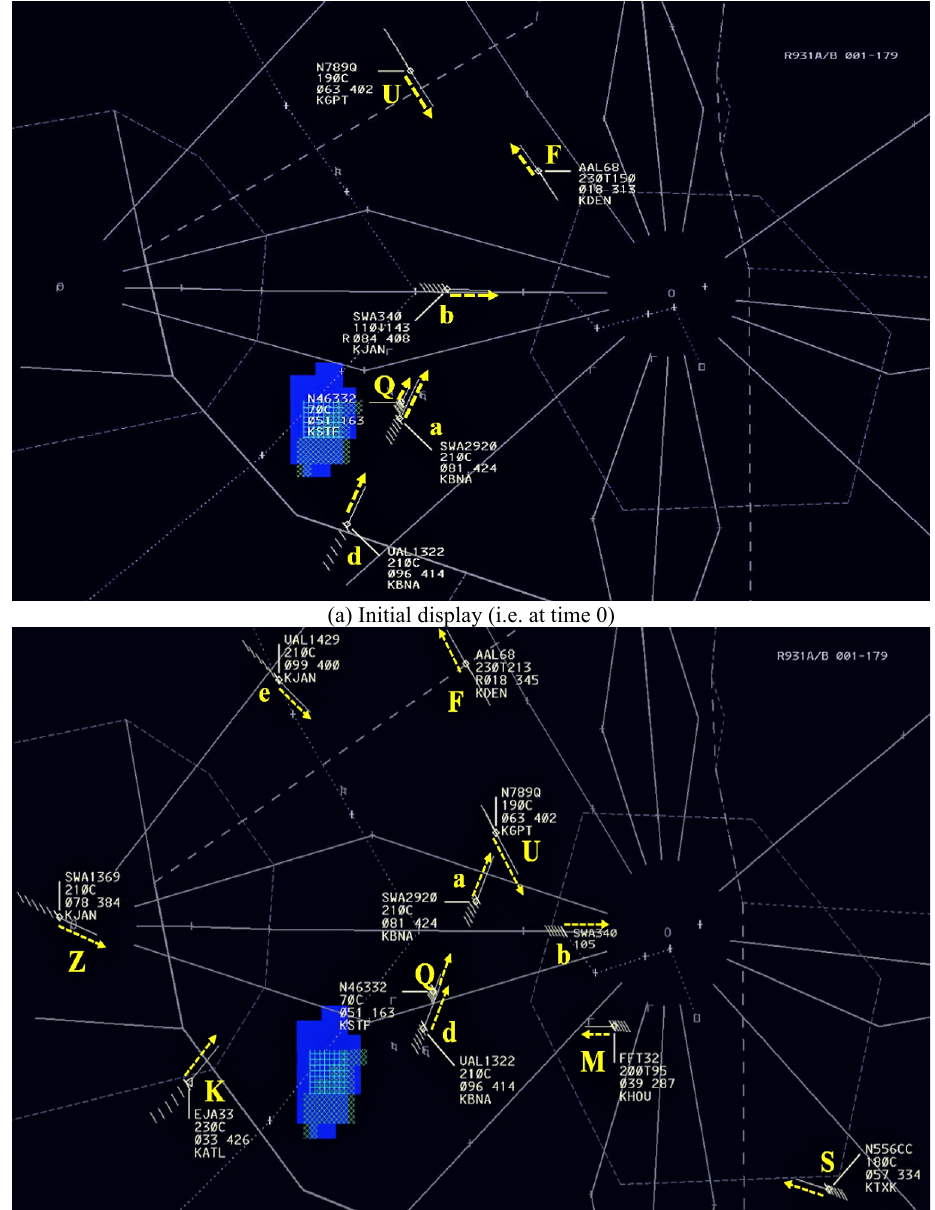
Figure 7. Screen captures at the 0 and 5 minutes. The blue patch shows a weather feature (e.g. thunderstorm) which the aircraft needs to avoid. The characters and arrows in yellow color represent an AOI and the direction of the aircraft, respectively. These characters and arrows were not present during the experiment. Each AOI consists of an aircraft shown as a diamond shape, its direction shown as a vector line, and its associated data block (first line shows the aircraft ID, second line shows its altitude, third line shows its com- puter ID and speed, and forth line shows its destination). If the altitude changes, the aimed altitude is shown followed by letter “T” and the current altitude. For example, AOI F is AAL68 (i.e. American Airlines 68) and flying toward northwest. Its current altitude is 21,300 ft (at 5 minutes) and target altitude is 23,000 ft. Its speed is 345 knots (at 5 minutes) and destination is KDEN (i.e. Denver international